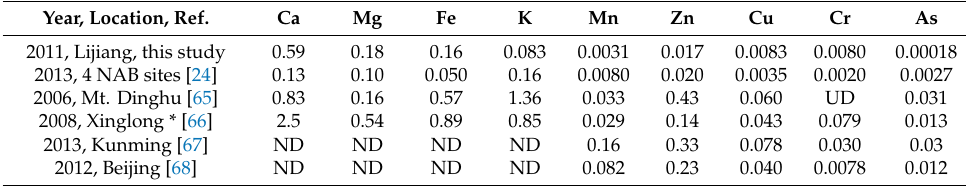
Table 6. Concentrations of elements in PM 2.5 of di ff erent sites ( µ g / m 3